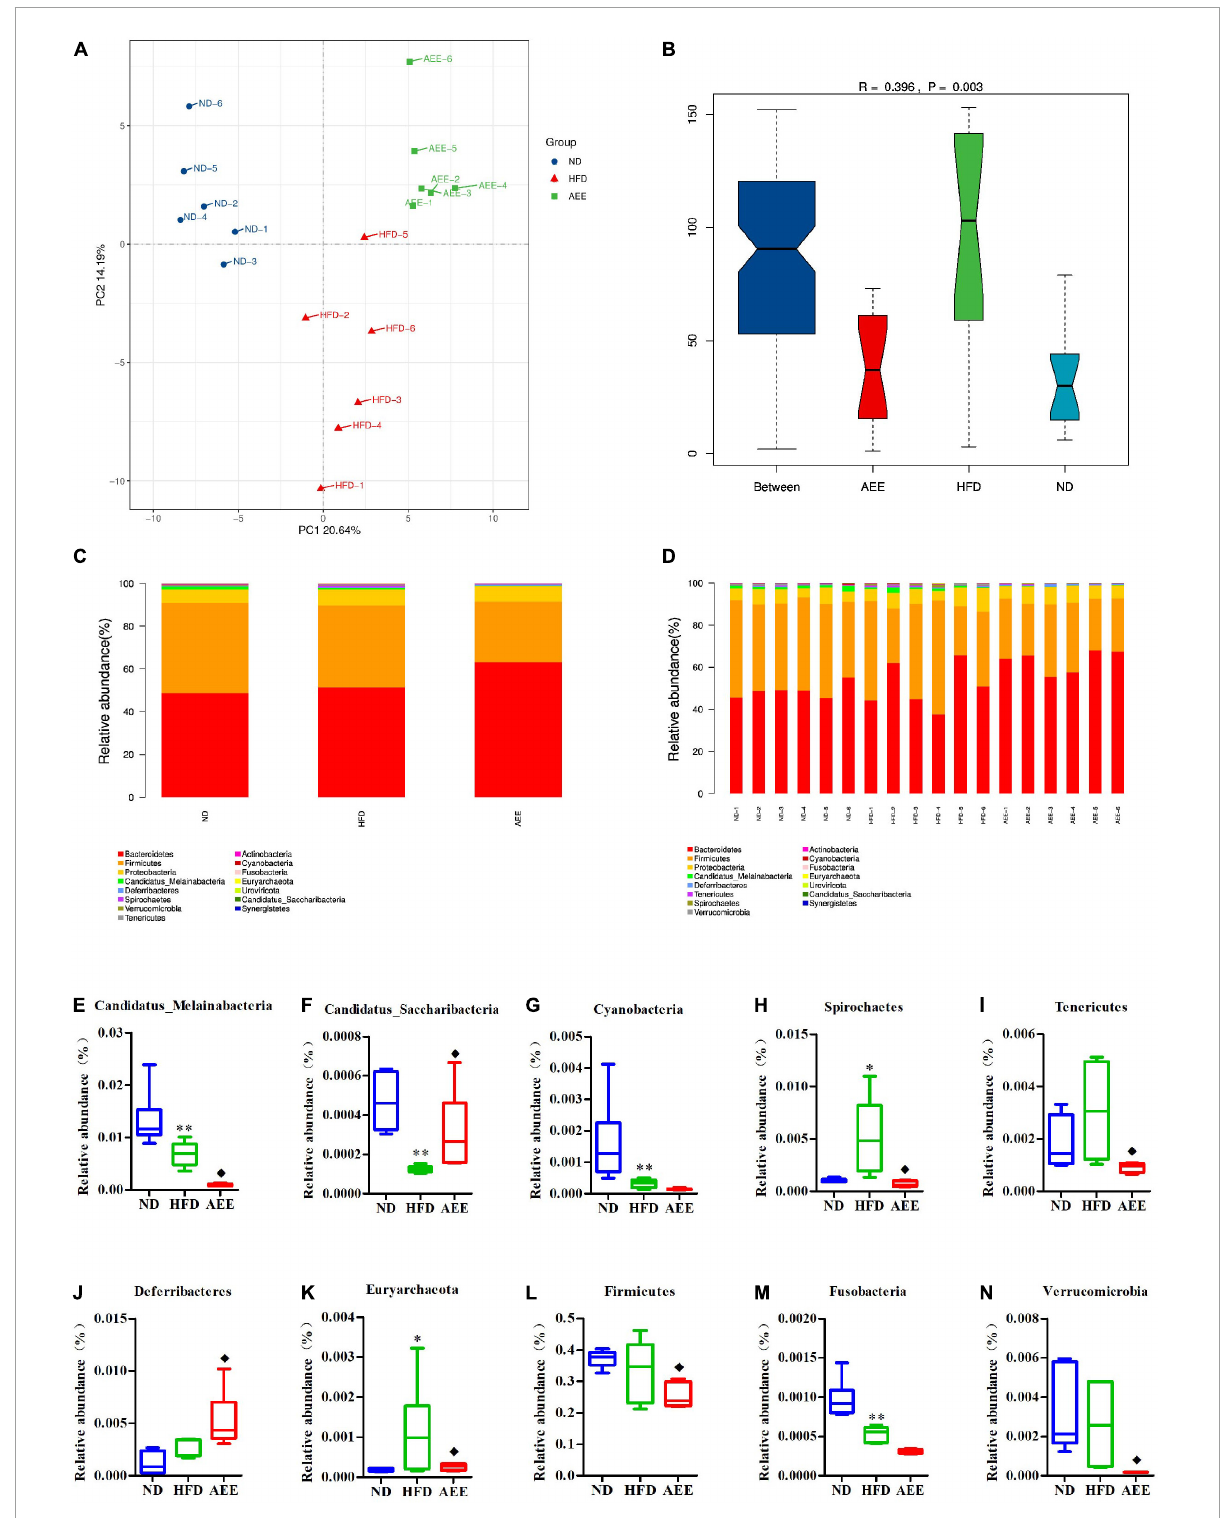
FIGURE6 Microbiota compositions at the Phylum level. (A) PCA results of the similarities in bacterial community structures at the Phylum level. (B) Analysis of Anosim based on Phylum level. (C,D) Histogram of relative abundance at the Phylum level. (E–N) Relative content of Candidatus_Melainabacteria, Candidatus_Saccharibacteria, Cyanobacteria, Deferribacteres, Euryarchaeota, Firmicutes, Fusobacteria, Spirochetes, Tenericutes, and Verrucomicrobia at the Phylum level. Values are presented as mean ± SD ( n = 6). Differences were assessed by ANOVA and denoted as follows: ∗∗ P < 0.01, ∗ P < 0.05 compared with the ND group; (cid:117) P < 0.05 compared with the HFD